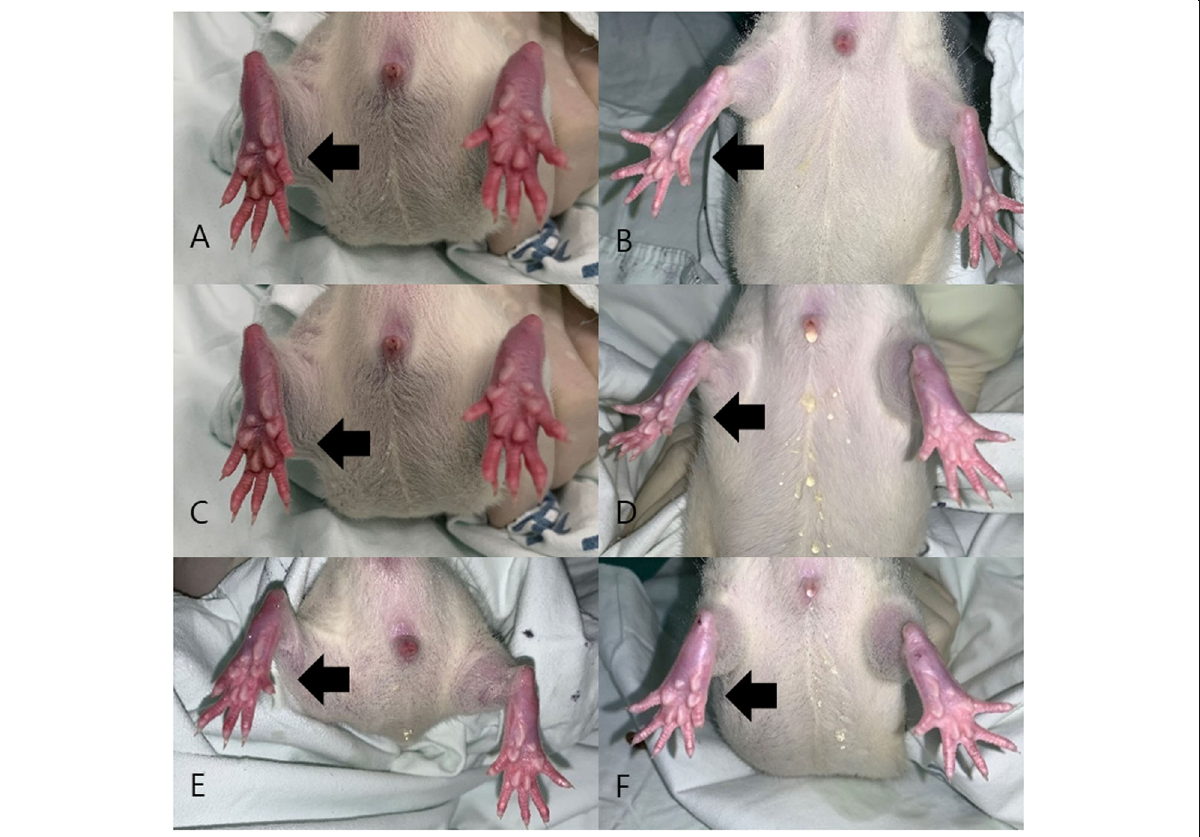
Fig. 3 Images of the sole. A Representative of group A at 2 weeks. B Representative of group A at 4 weeks. C Representative of group B at 2 weeks. D Representative of group B at 4 weeks. E Representative of group C at 2 weeks. F Representative of group C at 4 weeks. Both feet are spread evenly (arrow) in panels A and B . The left foot appears crooked compared to the right foot (arrow) in panels C and D . The left foot appears crooked compared to the right foot in panel E ; however, the left foot appears to have recovered slightly (arrow) in panel